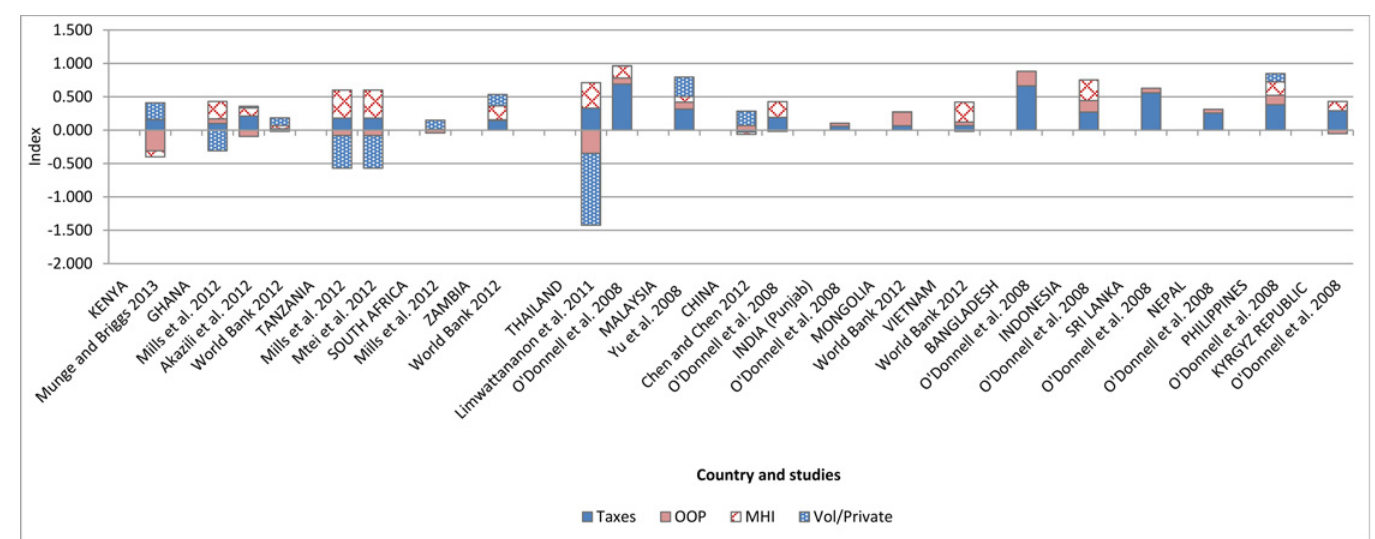
Fig 3. Kakwani indices for the four main financing sources reported by FIA studies from sub-Saharan Africa and Asia-Pacific.